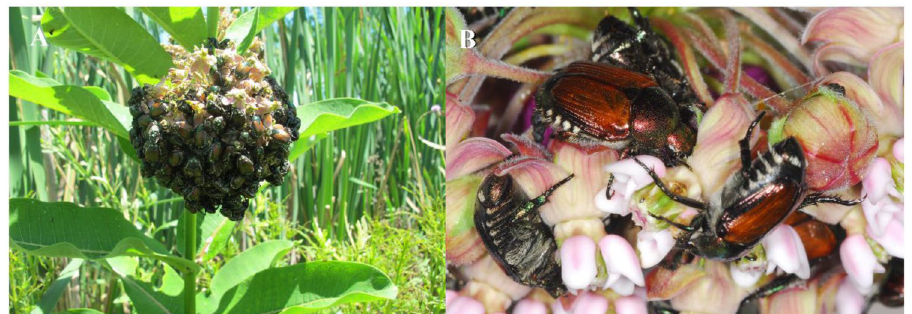
Figure 2. Japanese beetle [JB] feeding on common milkweed, Asclepias syriaca . ( A ) Aggregation of 288 JB on milkweed umbel (inflorescence). Infestations and florivory were widely observed in 2016–2018 and occurred on > 90% of surveyed plants. (B) JB biting into coronal hoods of individual flowers.